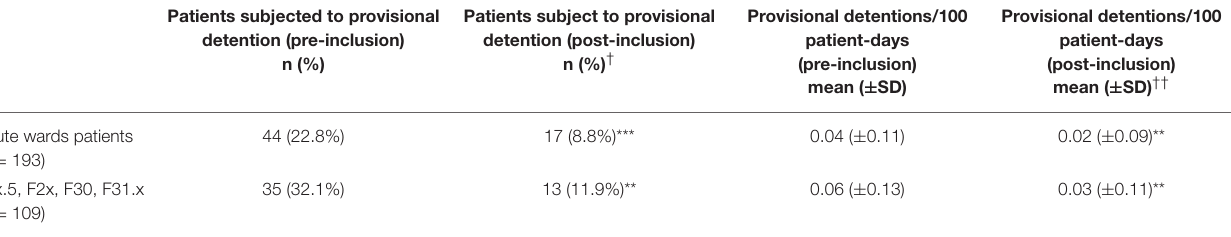
TABLE 3 | Number of patients subjected to provisional detention and average number of provisional detentions before and after inclusion in the model project. Patients subjected to provisional detention